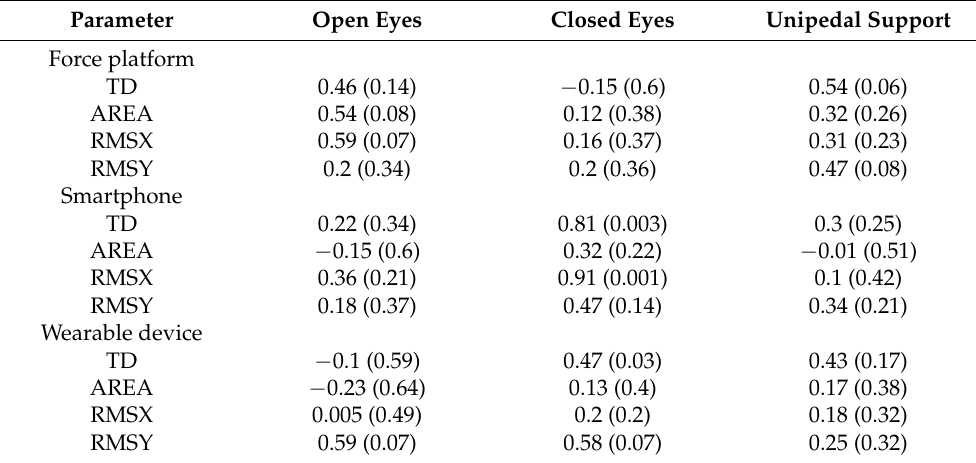
Table 4. Test- retest reliability ( p -value) of the parameters obtained by force platform, smartphone, and wearable in the different experimental conditions in a subsample of the present investigation (n =